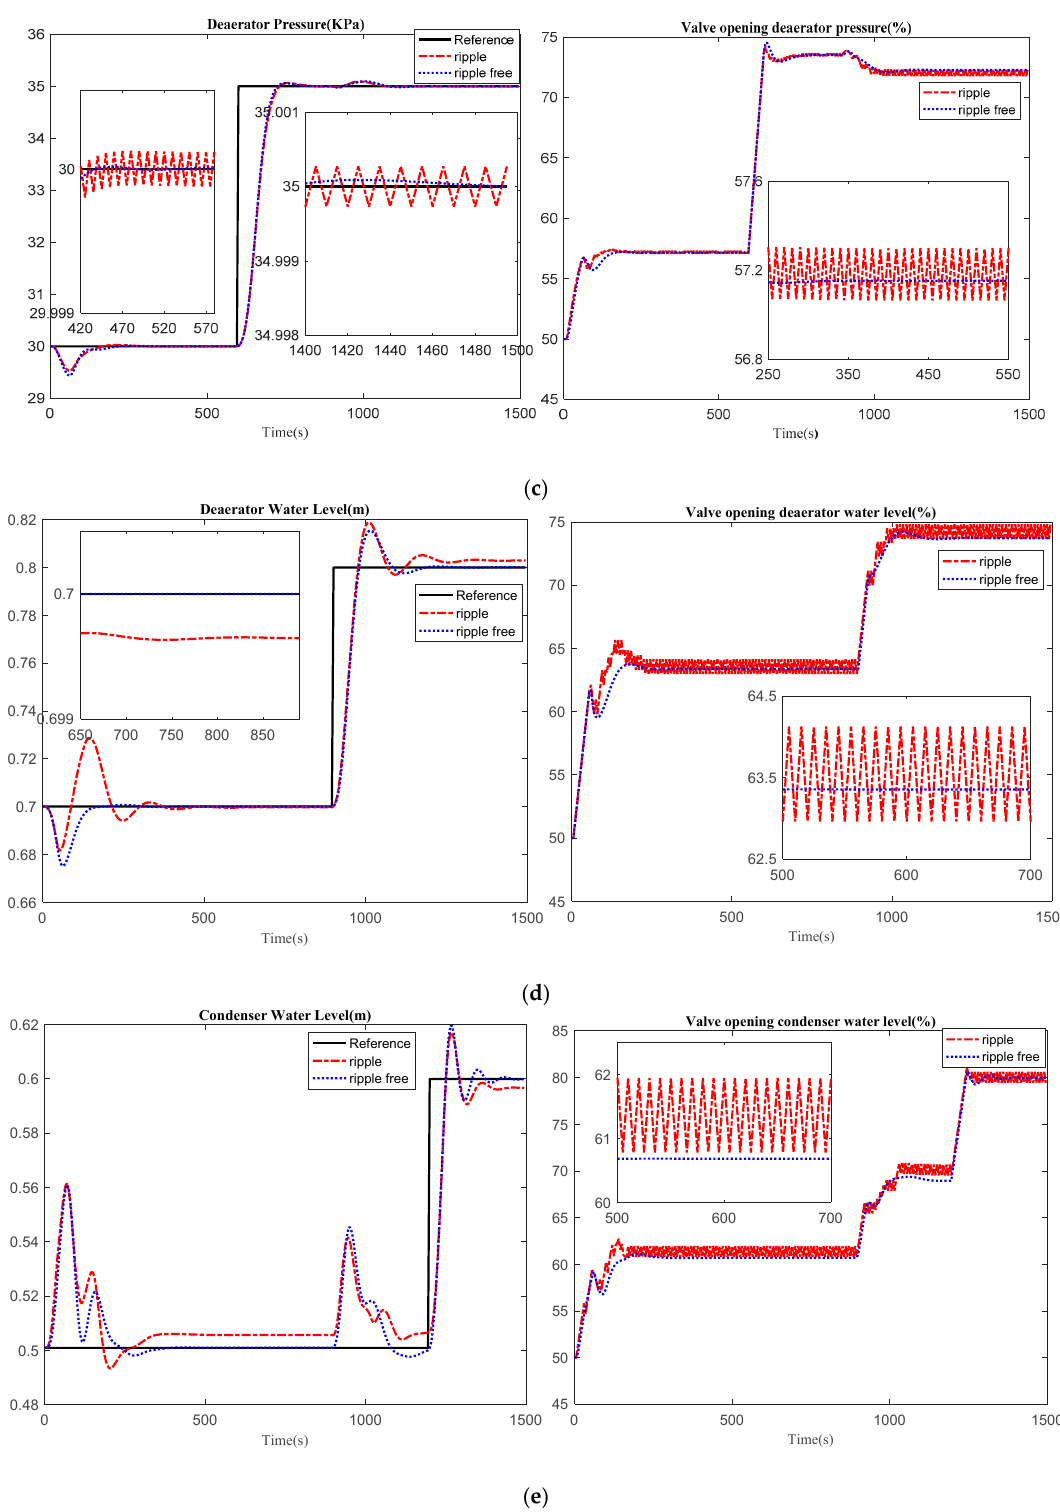
Figure 3. Responses of the steam/water loop under the EPSAC and ripple-free EPSAC for ( a ) drum water level control loop, ( b ) deaerator water level control loop, ( c ) deaerator pressure control loop, ( d ) condenser water level control loop and ( e ) exhaust manifold pressure control loop (The figures on left-hand indicate the outputs, and on the right-hand indicate the inputs).